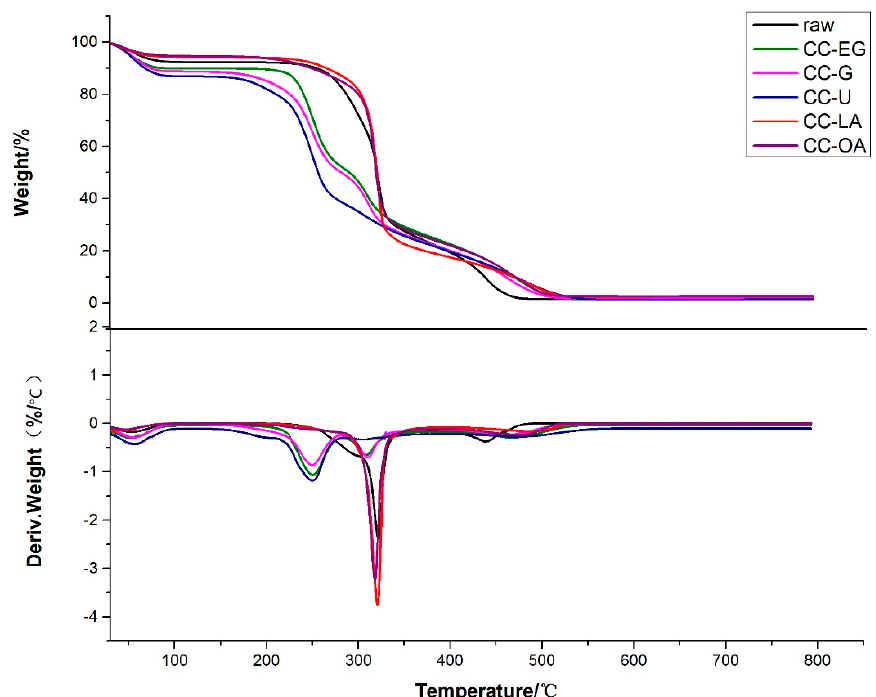
Figure 7. TG/DTG curves of bagasse cellulose treated with different DESs.